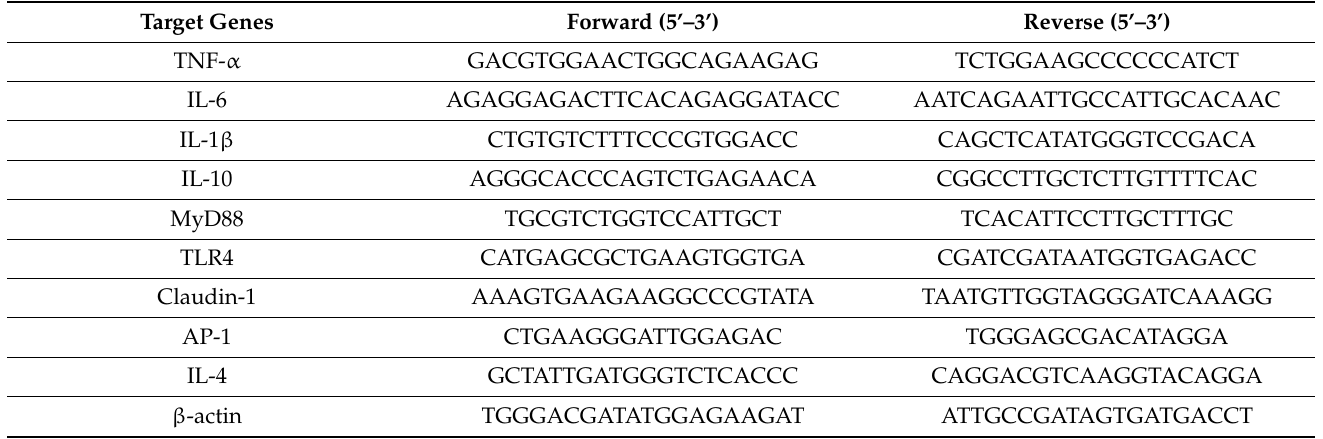
Table 1. The primer sequences and their target